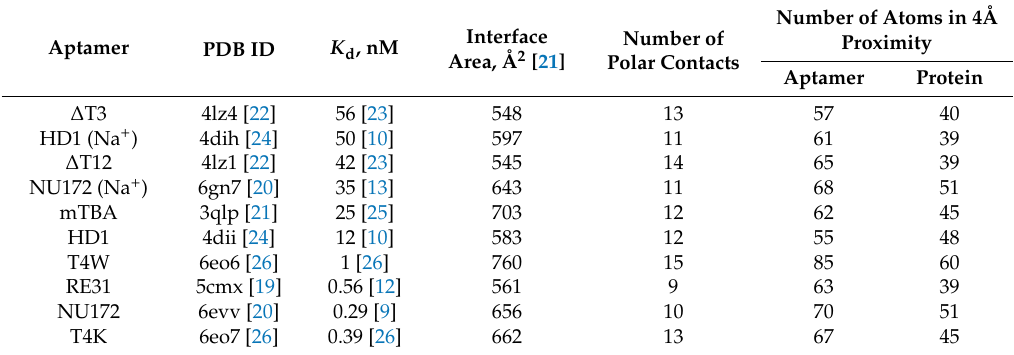
Table 4. Characteristics of aptamer–thrombin complexes. The complexes are ordered according to their apparent dissociation